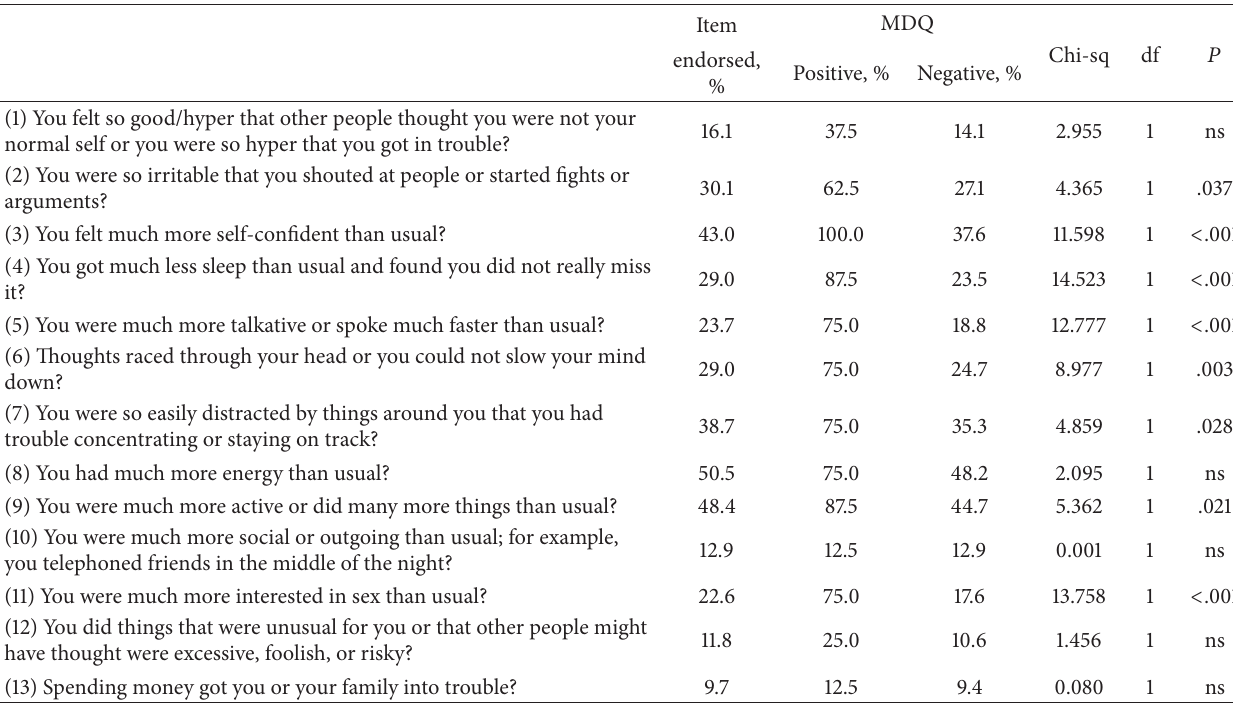
Table 3: Frequencies of endorsed items to MDQ (standard cut-off ∗ ) and correlation with positive screening.